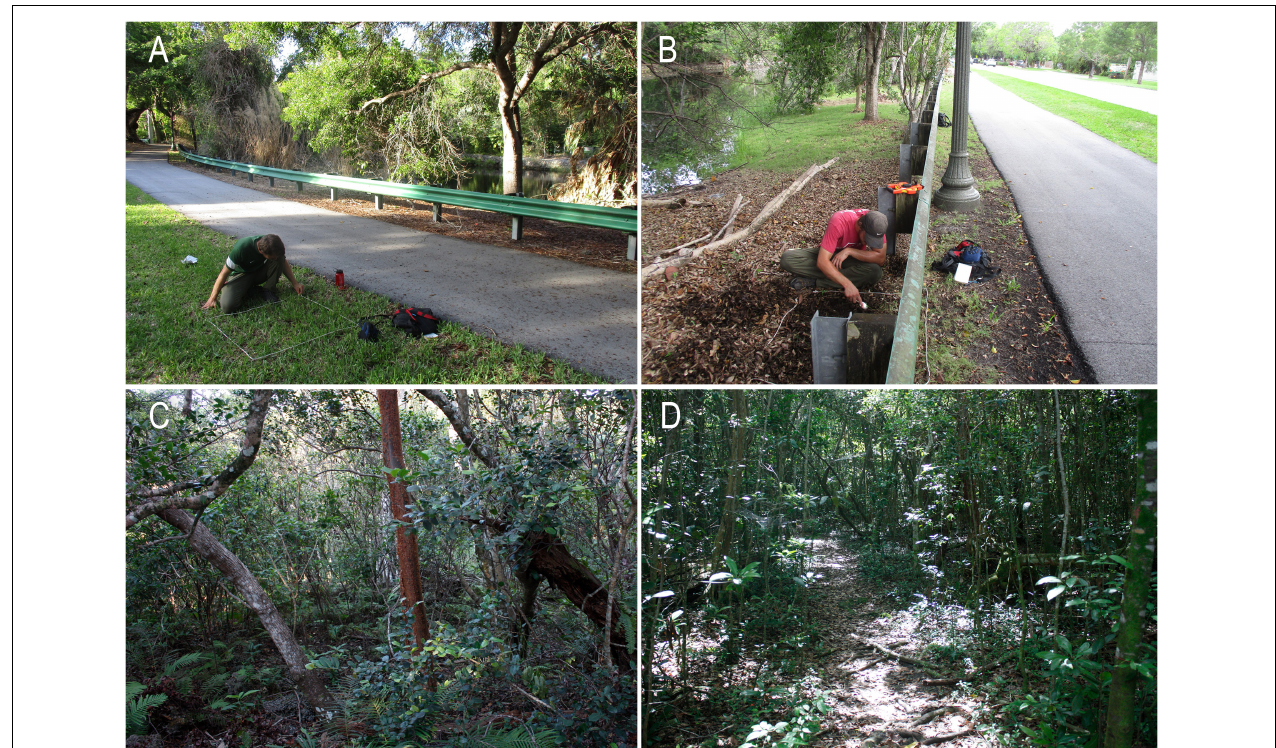
FIGURE 3 | Photographs of suburban (A,B) and forested (C,D) habitats where anole nesting ecology was studied in Miami-Dade County, FL, United States. Note that the suburban site includes mowed lawn, roads, and a walking path. The same egg search methods were used in both habitats.